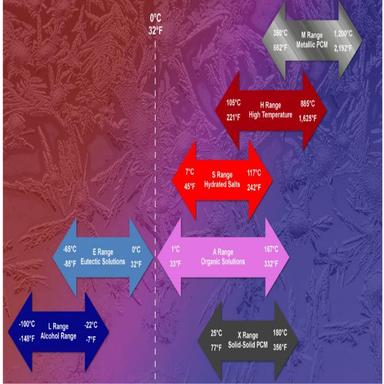
Commercially available PCM and their temperature ranges PCM Products Ltd..